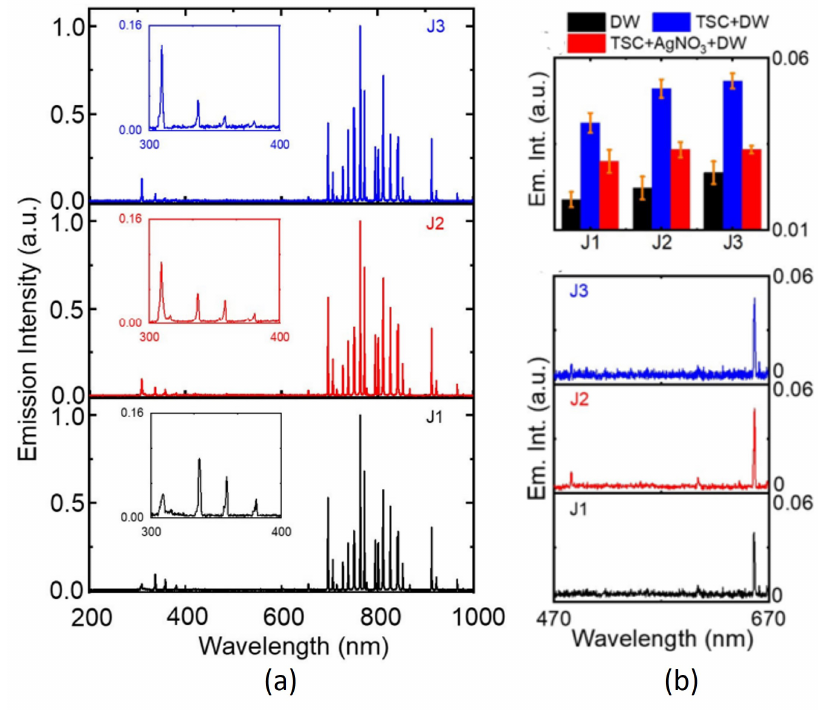
Figure 4. ( a ) Optical emission spectra of the J1, J2, and J3 jets in the 200–1000 nm range. The 309 nm and 330–380 nm emission bands correspond to the hydroxyl radical and the second positive system transition of nitrogen molecules, respectively. ( b ) ( top ) Hydrogen emission intensities of DW, TSC- DW, and AgNO 3 -TSC-DW treated for 10 min with the J1, J2, and J3 jets. ( bottom ) Hydrogen emission spectra of AgNO 3 -TSC-DW treated for 10 min with the J1, J2, and J3